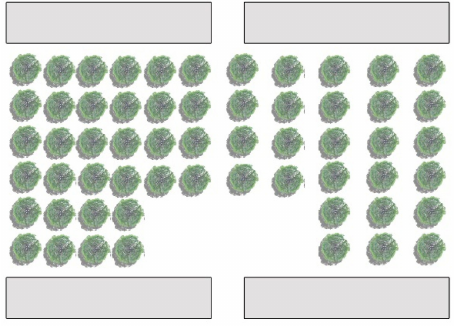
Figure 17. An example of tree